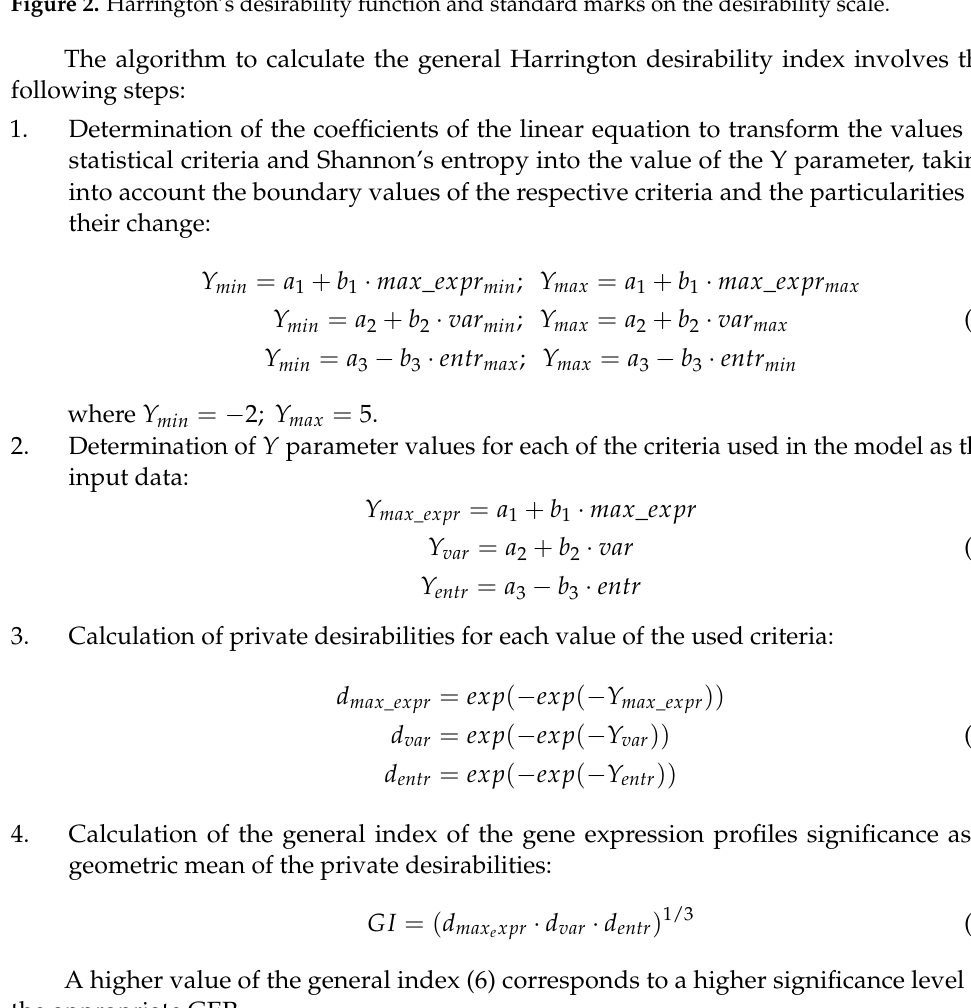
Figure 2. Harrington’s desirability function and standard marks on the desirability